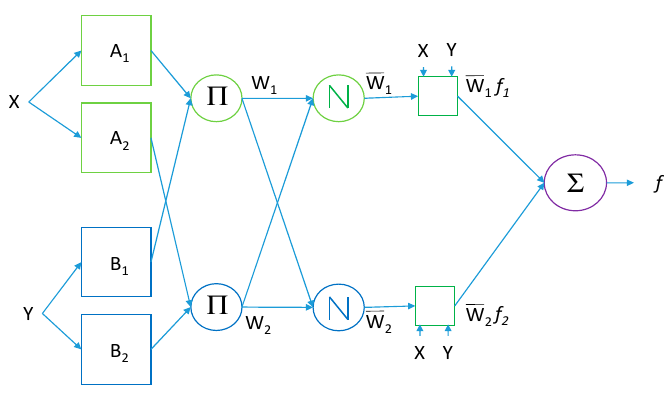
Figure 8. The ANFIS-based fuzzy system for two rules.